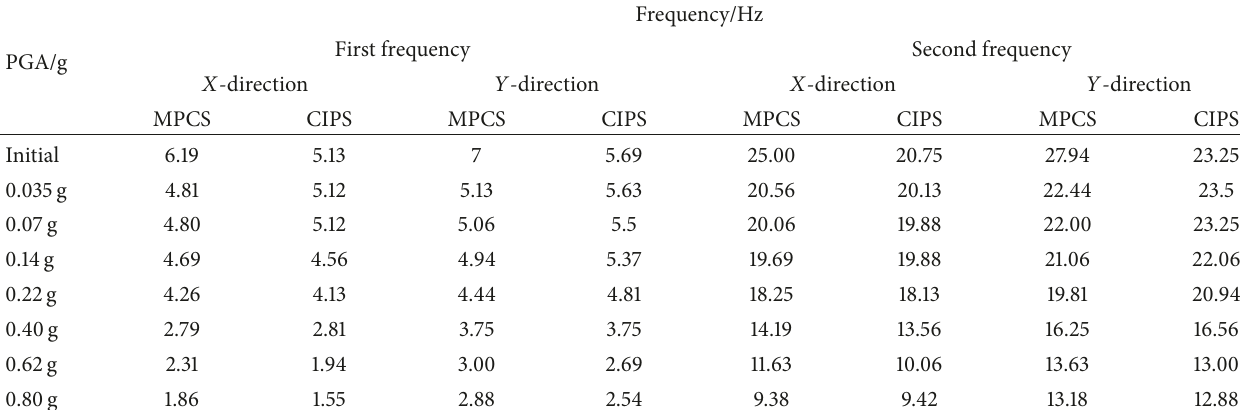
Table 2: Natural frequency of CIPS and